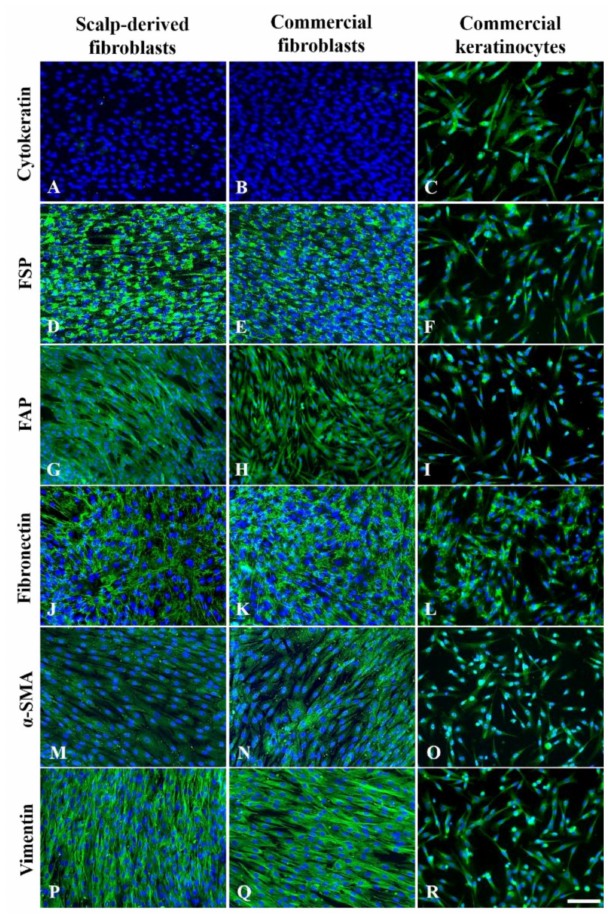
Figure 4. Representative expression profiles of various markers in postmortem scalp-derived fibroblasts, commercial dermal fibroblasts, and commercial keratinocytes. The presence of green immunofluorescence shows the positive staining of the markers: ( A – C ), cytokeratin; ( D – F ), FSP (fibroblast surface protein); ( G – I ), FAP (fibroblast activation protein); ( J – L ), fibronectin; ( M – O ), α -SMA ( α -smooth muscle actin); ( P – R ), vimentin. The nuclei of cells are shown in blue fluorescence by DAPI dye. The top row shows the presence of cytokeratin immunoreactivity in keratinocytes but not in fibroblasts. All other markers are all positively detected in the postmortem scalp-derived and commercial fibroblasts. Scale bars represent 100 µ